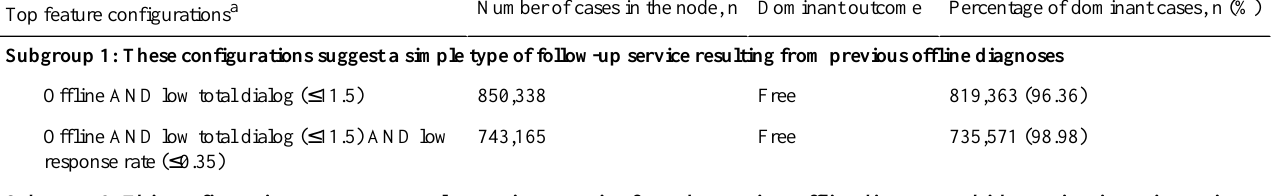
Table 5. Decision tree–based configuration of feature